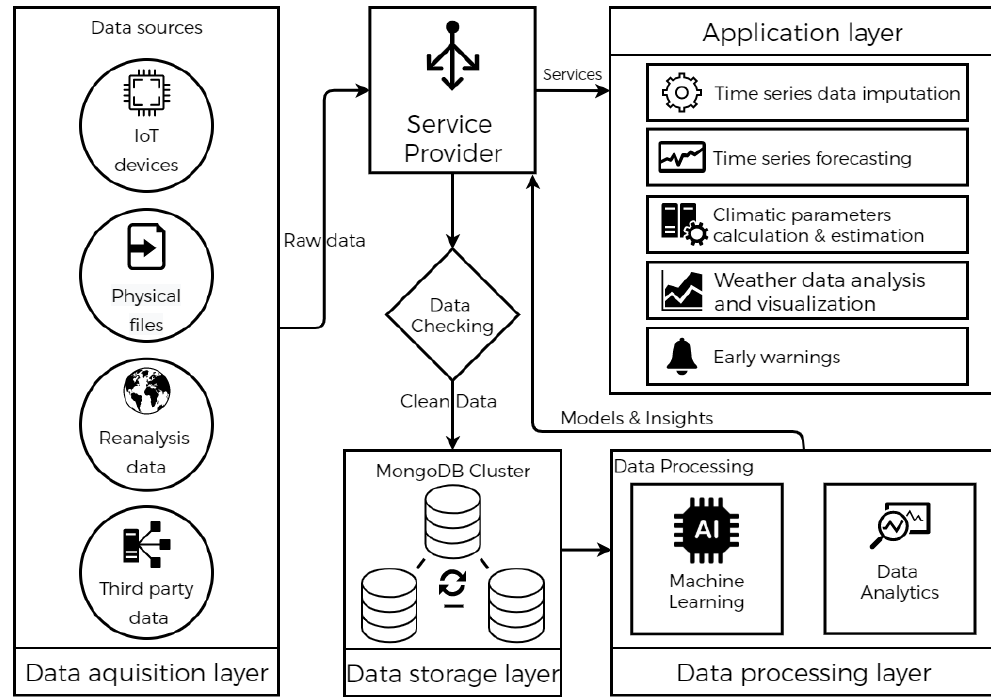
Figure 2. General architecture of the platform.